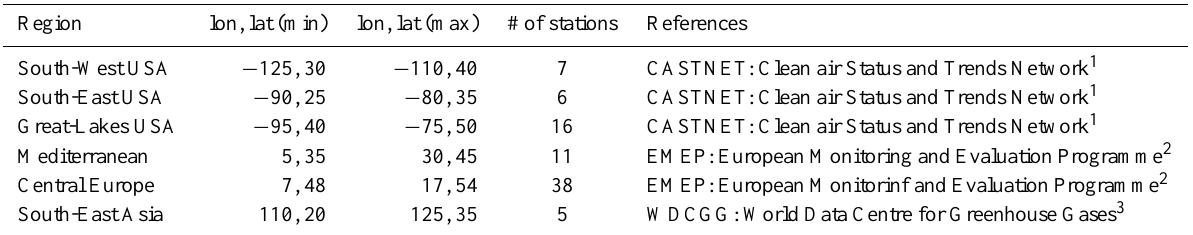
Table 3. Summary of regions used and data sources for model evaluation.